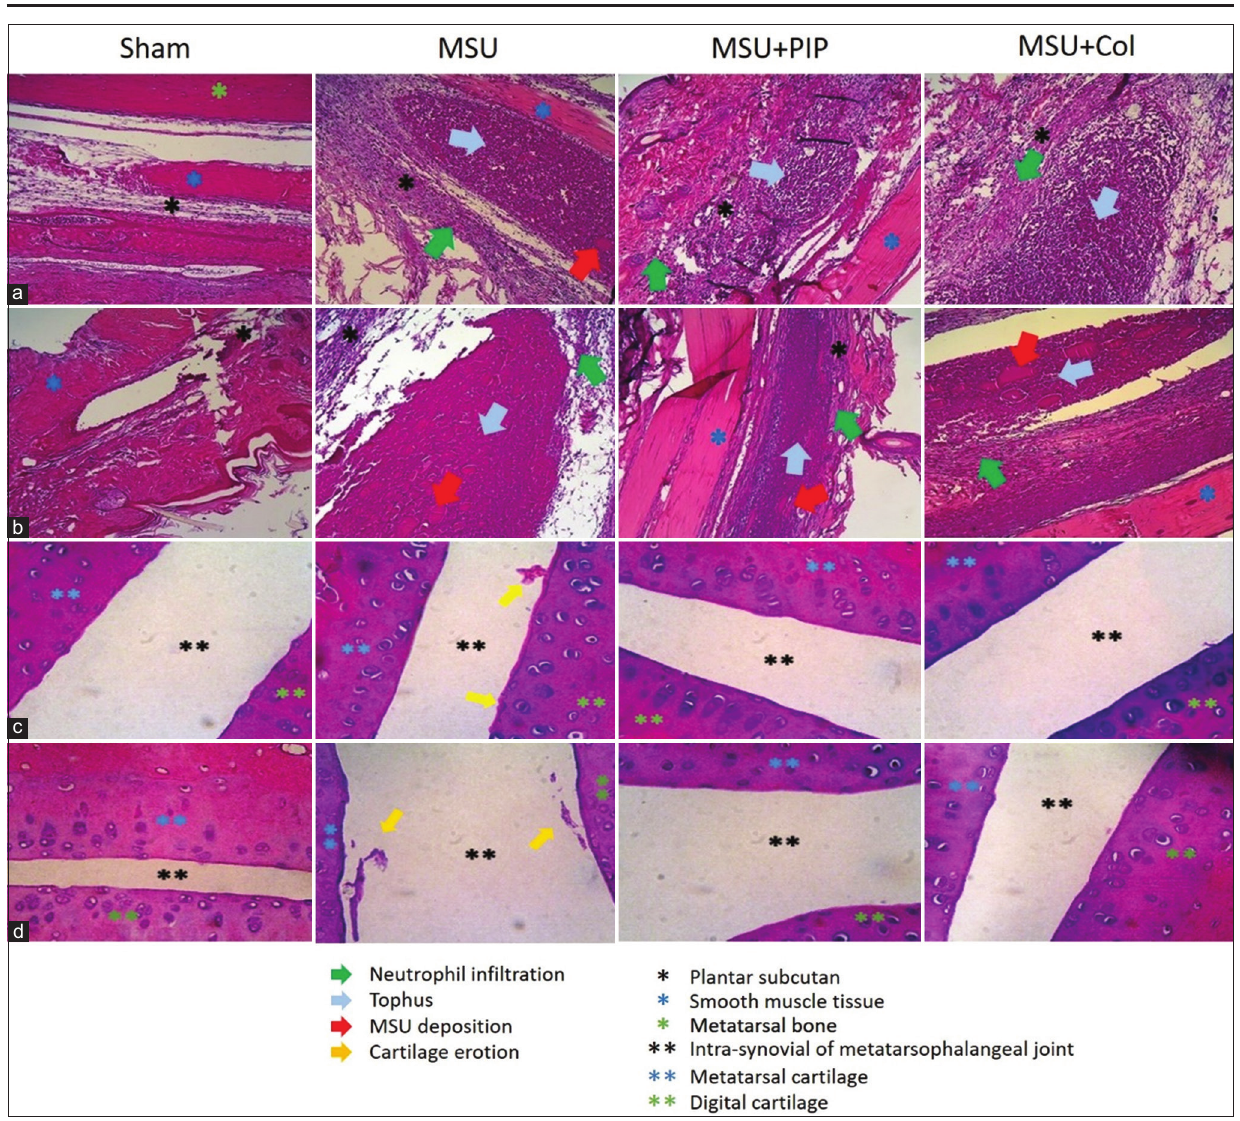
Fig ure-3: Effects of piperine on the reduction of tophus formation and cartilage erosion in a gout model rat due to intra- plantar injection of monosodium urate. (a and c) Hematoxylin and eosin (H&E) staining of rat plantar in protocol I. (b and d) H&E staining of rat plantar in protocol II. (a) Tophus formation and subcutaneous neutrophil infiltration 24 h post-injection. (b) Tophus formation and subcutaneous neutrophil infiltration 72 h post-injection. (c) Erosion of the metatarsophalangeal cartilage 24 h after injection. (d) Erosion of the metatarsophalangeal cartilage 72 h after